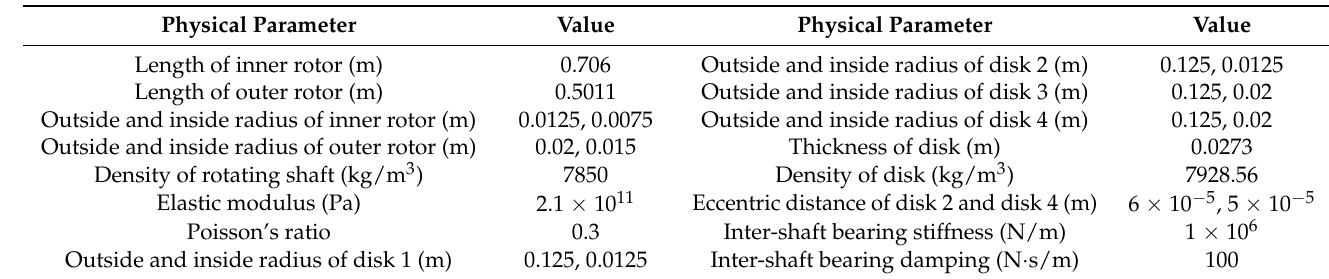
3 of 15 Figure 1. Finite element model of the MSDS. Table 1. The main parameters of the MSDS.. Physical Parameter